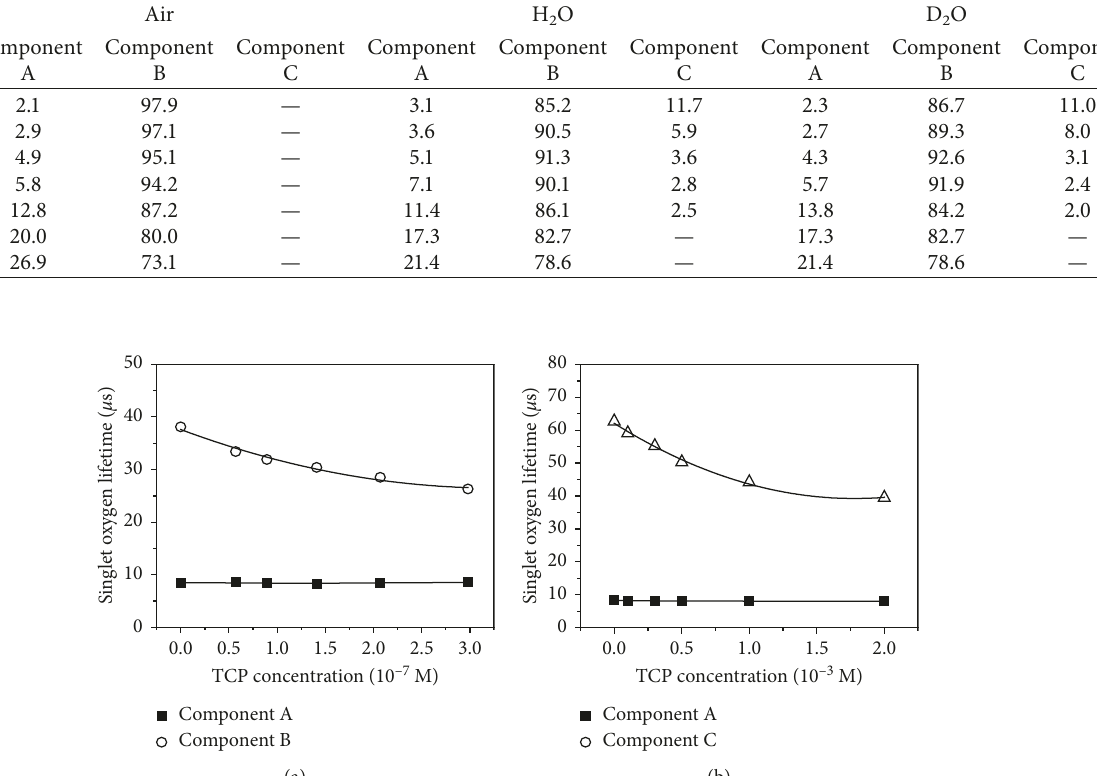
Table 3: Relative amplitudes of singlet oxygen phosphorescence from each component on PFPFs in the various environmental conditions. Relative amount of singlet oxygen (%) Sample